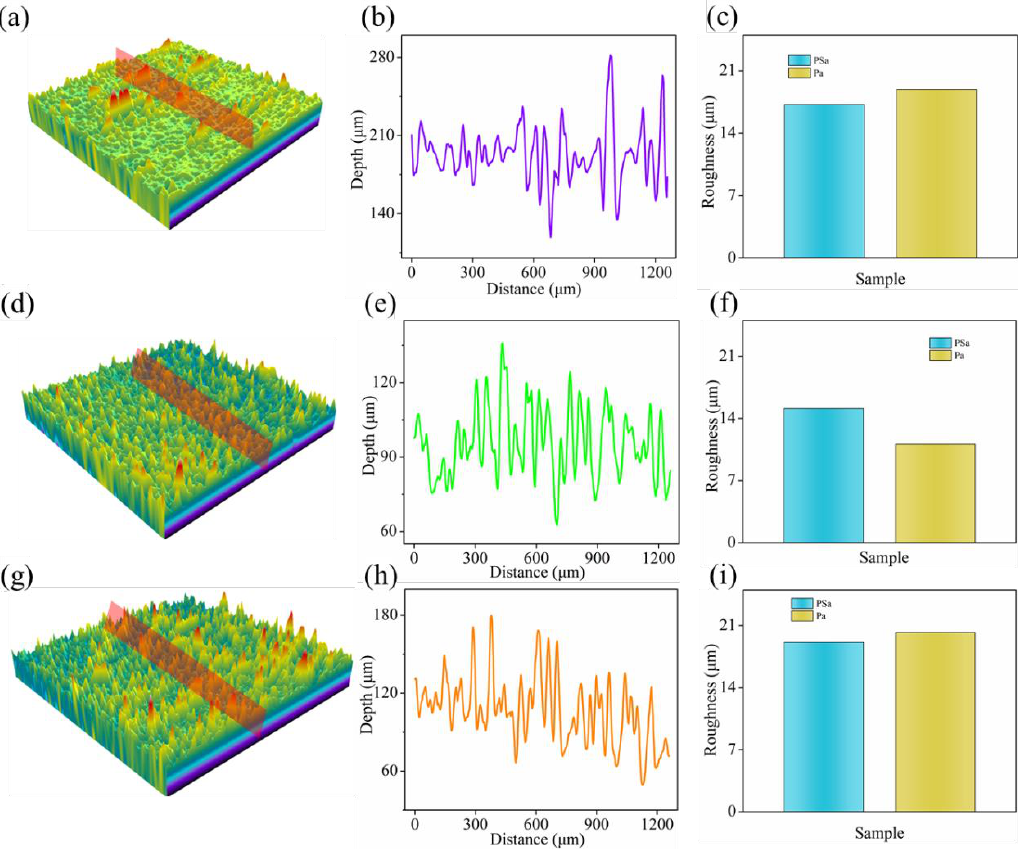
Figure 4. Representative AFM images of ( a ) AZ91, ( d ) AZ91S and ( g ) AZ91SG; Height profile along the red plane of ( b ) AZ91, ( e ) AZ91S and ( h ) AZ91SG with corresponding roughness for ( c ) AZ91, ( f ) AZ91S, ( i ) AZ91SG.